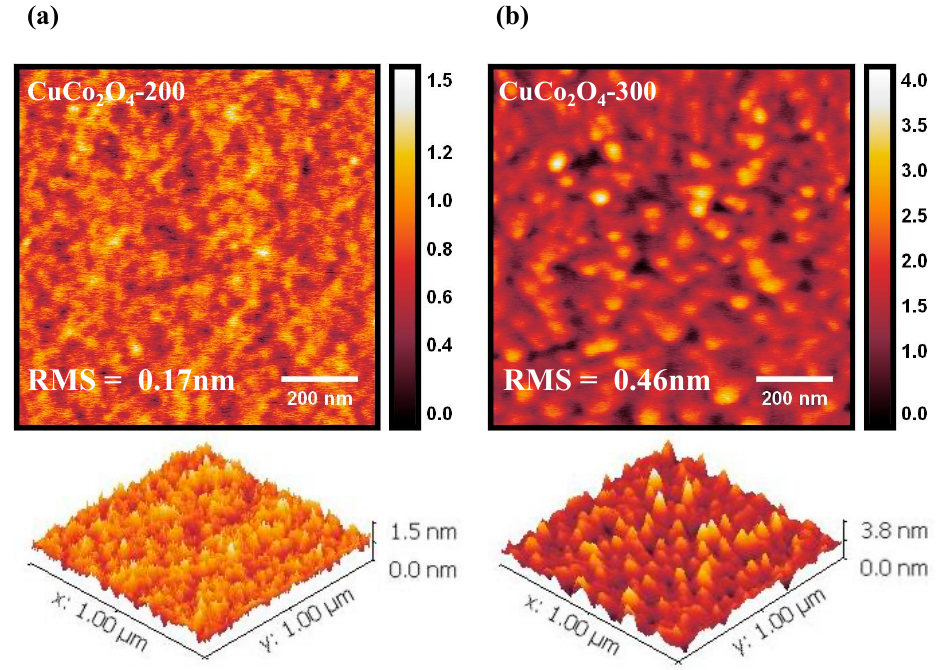
Figure 2. AFM topography image of ( a ) CuCo 2 O 4 -200 thin film and ( b ) CuCo 2 O 4 -300 thin film.